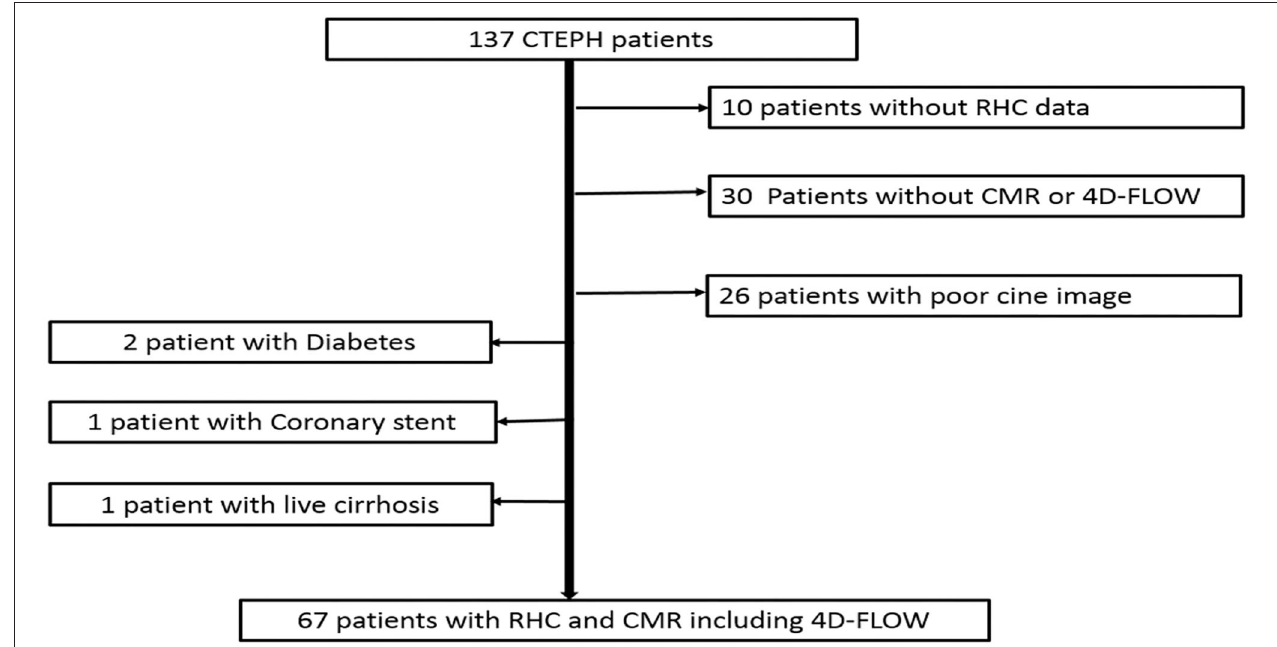
FIGURE 1 | A flowchart detailing how participants were selected.